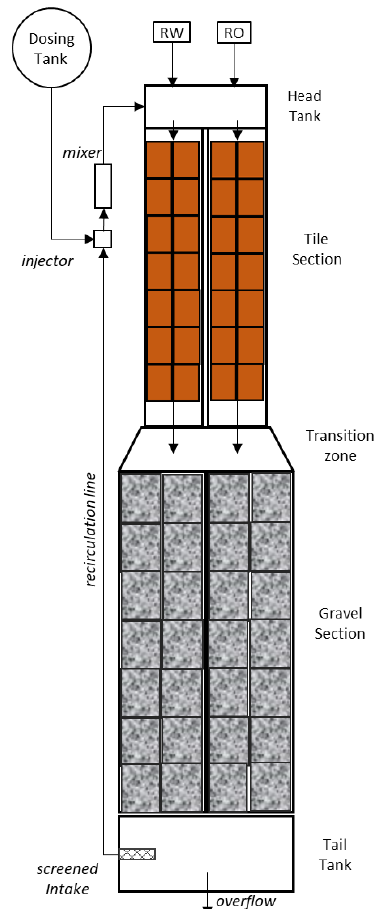
Figure 1. ESF mesocosms set-up for excess TDS dosing study. Each mesocosm represents one half of the channel unit depicted here. Two mesocosms shared a head and tail tank. Recipes are delivered from dosing tank. Unglazed terra cotta tiles depicted in orange. Gravel baskets depicted in textured grey. Abbreviations defined in text.